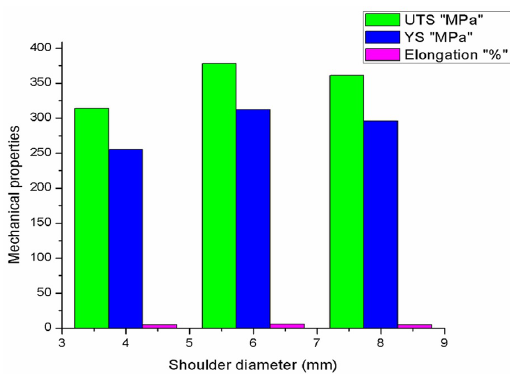
Figure 7: Effect of FSW parameters on macrostructure